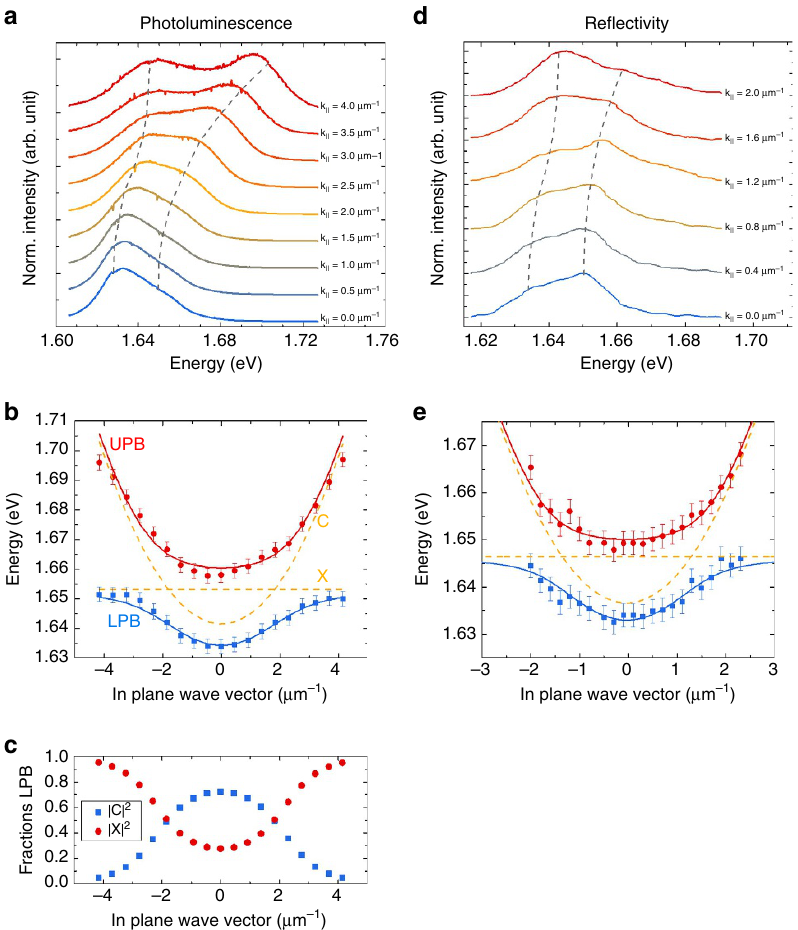
Figure 2 | Exciton-polariton formation with Tamm-plasmons. ( a ) PL spectra recorded from the coupled device at room temperature at various in-plane momenta (depicted in a waterfall representation). Two pronounced resonances evolve in the system, which feature the characteristic anti-crossing behaviour of exciton-polaritons. ( b ) Energy–momentum dispersion relation of the lower and upper polariton branch at room temperature: the polariton energies are extracted by fitting spectra at various in-plane momenta (solid symbols). A coupled oscillator approach is employed to fit the data and to demonstrate excellent agreement between experiment and theory (lines). ( c ) Plot of the exciton and photon fraction of the lower polariton branch as a function of the in-plane momentum extracted from coupled oscillator fit. ( d ) Inverted reflectivity spectra at different in-plane momenta. ( e ) Energy– momentum dispersion relation extracted from the reflectivity spectra.